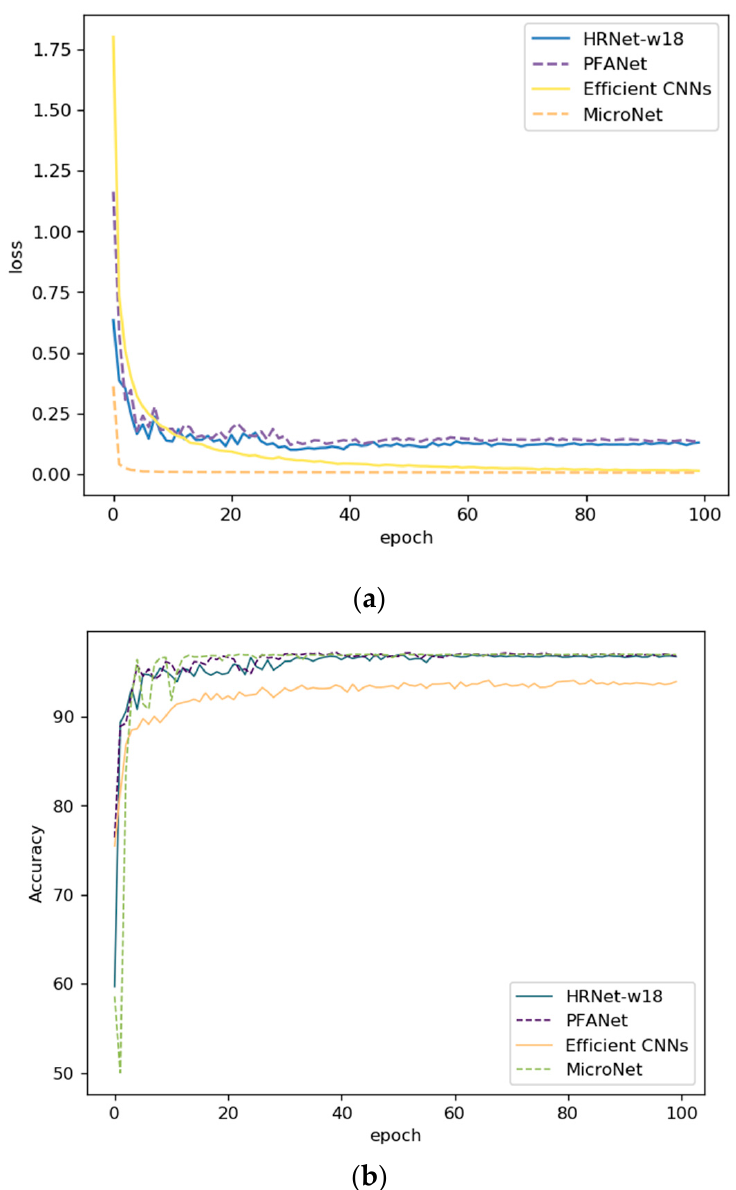
Figure 10. ( a ) The Training Loss curves on GTSRB. ( b ) The Training Accuracy curves on GTSRB.